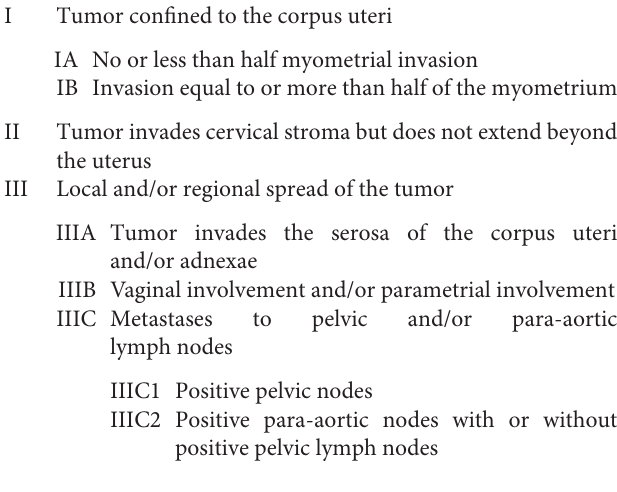
mutations and MLH1 promoter hypermethylation, whereas serous carcinomas show mostly TP53 mutations (27). Because of the limitations of this classification due to the wide molecular heterogeneity and, in turn, due to the discrepancy between the detected molecular pattern and tumor behavior, The Cancer Genome Atlas (TCGA) Research Network has gone further in the EC molecular landscape, providing more detailed molecular subclassifications, characterized, respectively by POLE mutation, mismatch repair deficiency, TP53 mutation, and a copy number low group without a specific driver mutation, each with a distinct prognosis (28): (i) POLE (ultra-mutated) tumors, (ii) microsatellite unstable (MSI) tumors, (iii) copy number high tumors with mostly TP53 mutations, and (iv) a remaining group without these alterations